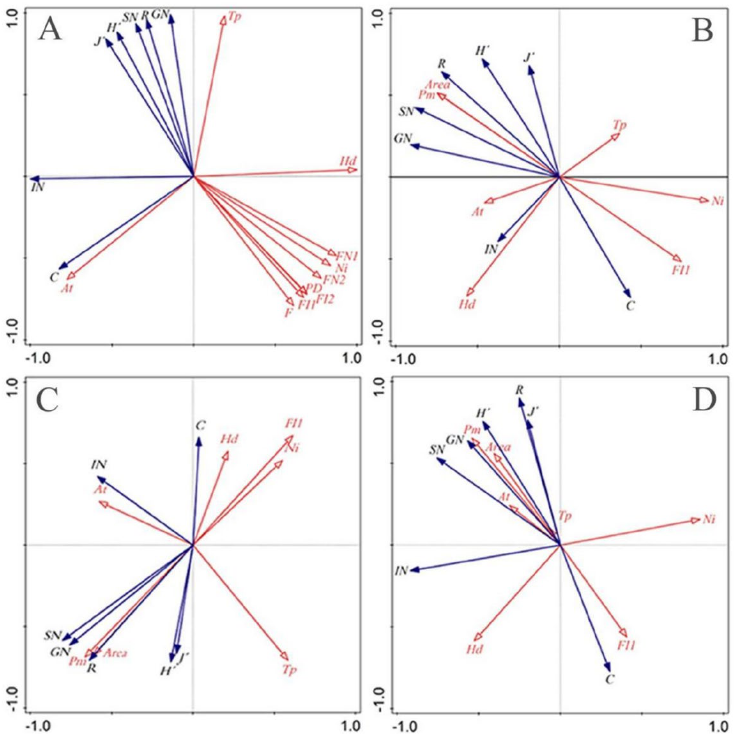
Figure 9. Redundancy analysis of species diversity and geographical environment factors of Ery- throneurine leafhoppers in different study areas (( A ): study area; ( B ): Shibing; ( C ): Bijie; ( D ):